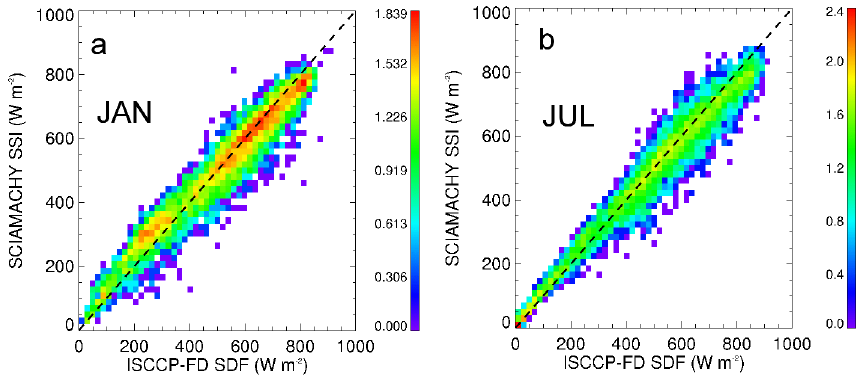
Fig. 9. Scatter density plots of the SCIAMACHY surface solar irradiances (SSI) versus the ISCCP-FD surface shortwave downwelling fluxes (SDF) for (a) January and (b) July 2006. The dashed line is the one-to-one line. The color scale indicates the logarithm of the number density of the data points.